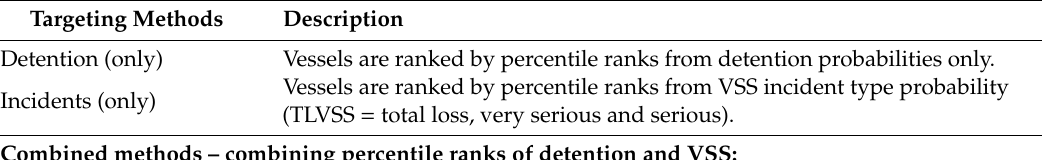
Table 3. Targeting methods evaluated.